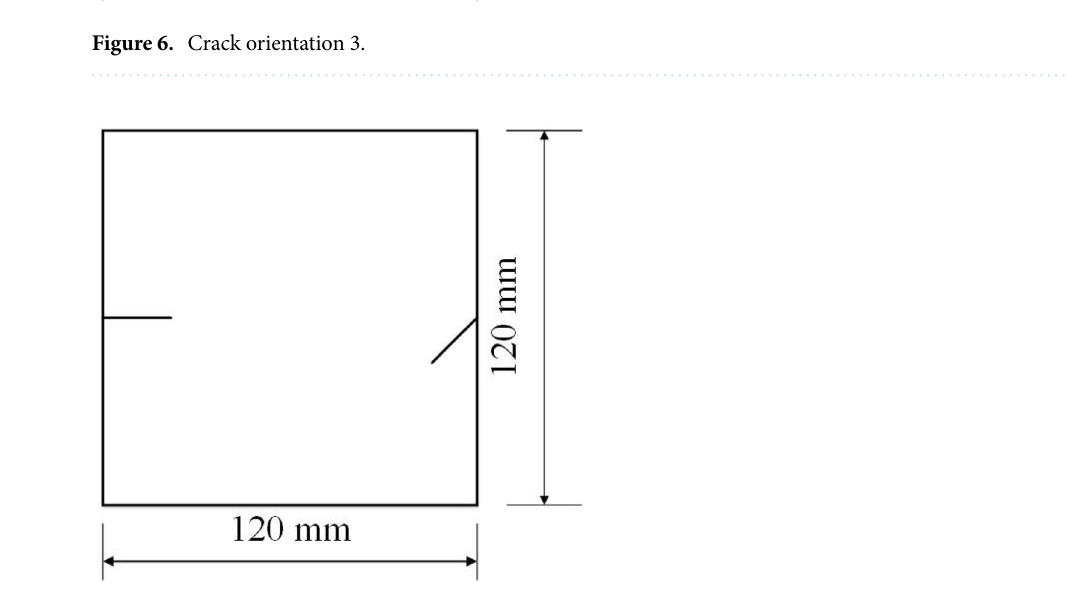
Figure 7. Crack orientation